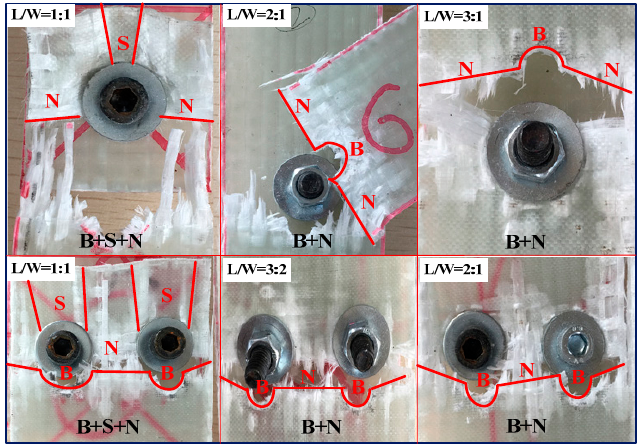
Figure 8. The final damage modes of the composite bolted joints after the tensile tests (In this figure, N indicates net-tension, S indicates shear out, and B means bearing failure mode).